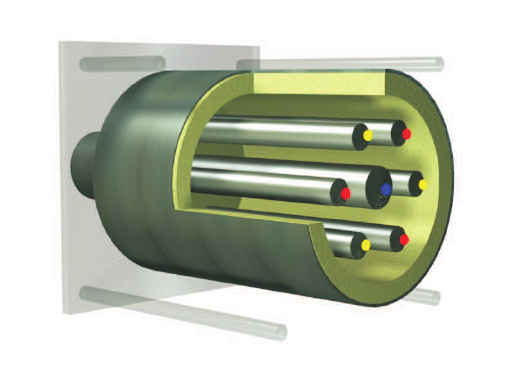
Figure 1. The heat